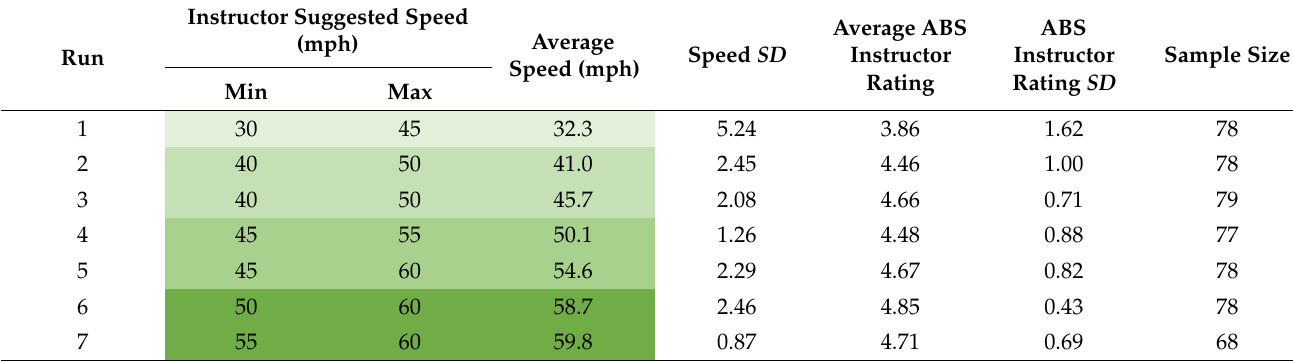
Table 5. The target speed provided by the instructors (which varied between drivers, therefore the range, average speed, standard deviation ( SD ) are included as well as the instructors’ average ABS rating and standard deviation. Since the sample size varied slightly for each run, the sample size is also